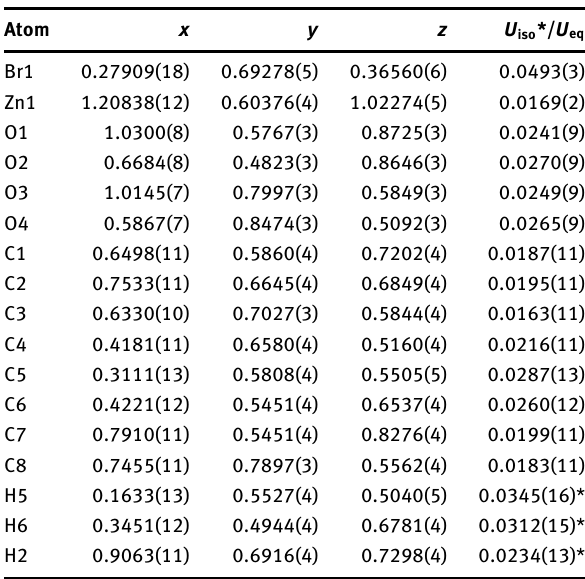
Apartofthemolecularstructureisshowninthefigure.Table1 contains crystallographic data and Table 2 contains the list